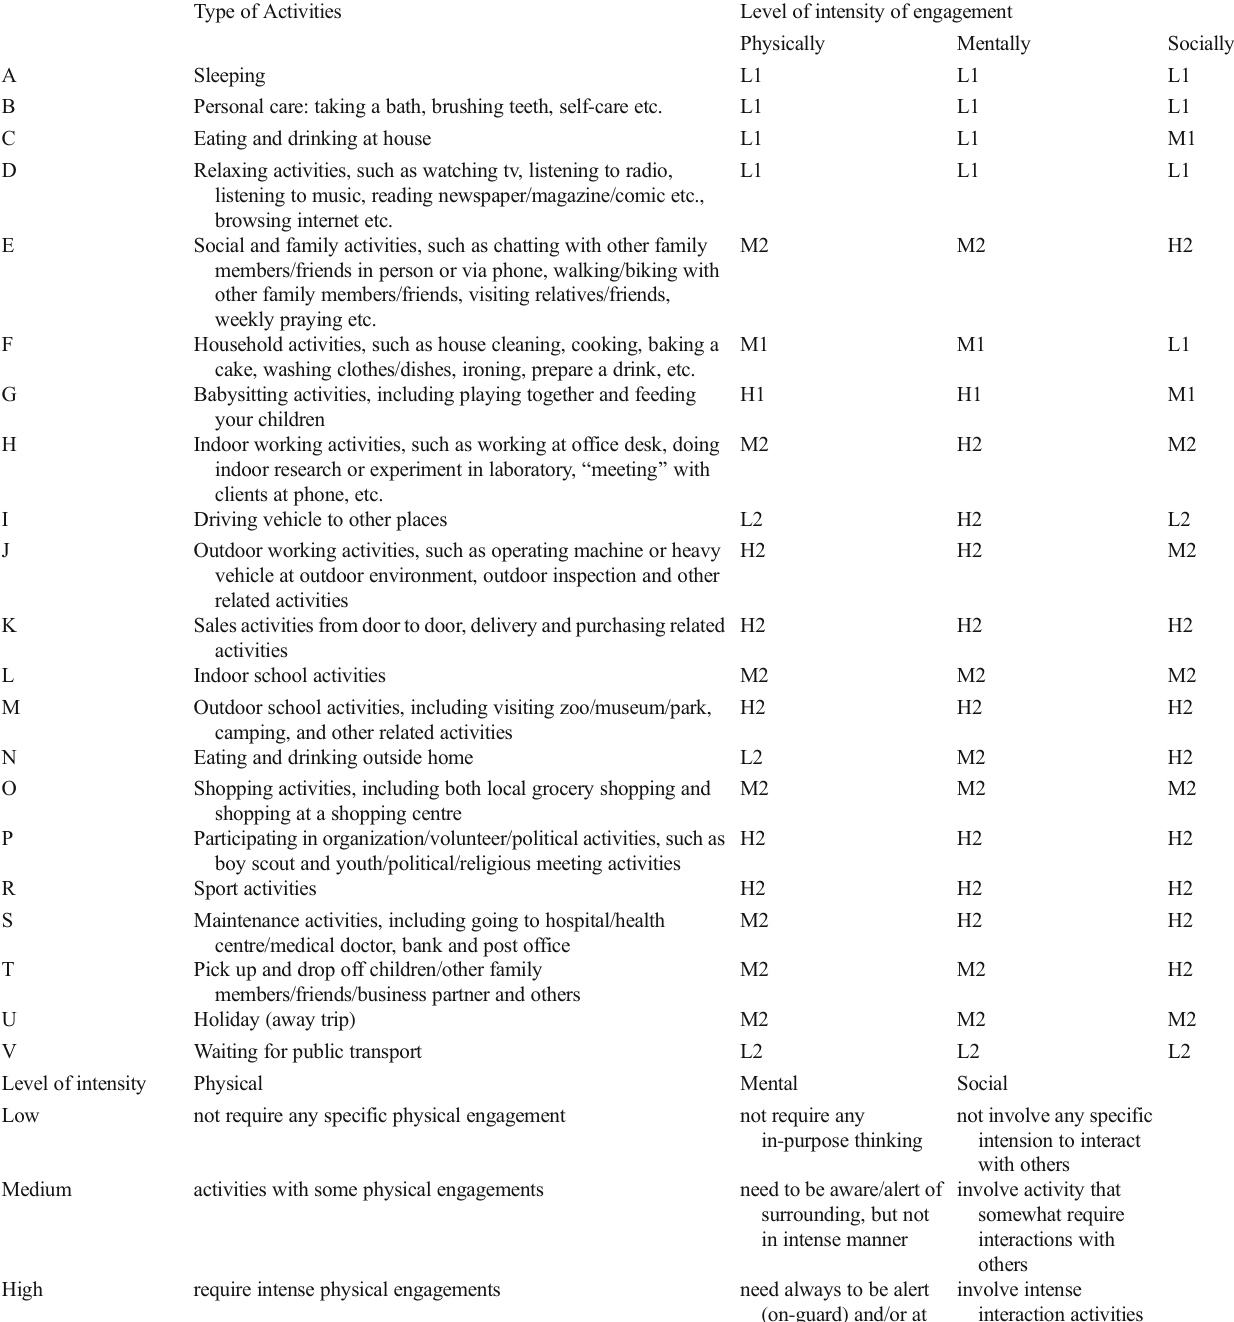
Table 3 Classification of activities and their intensities Type of Activities Level of intensity of